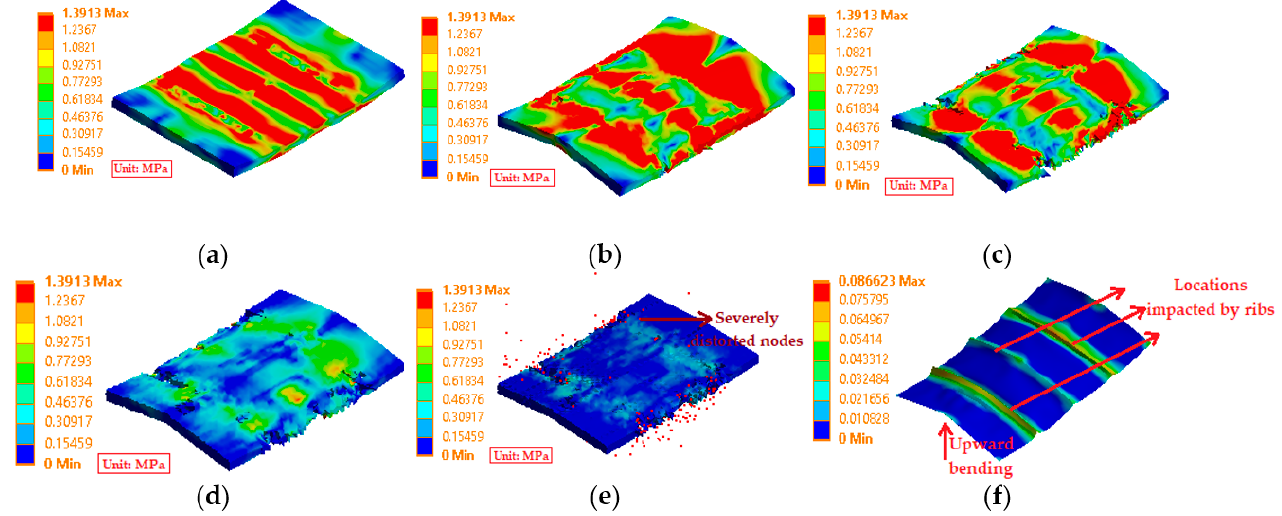
Figure 6. Maximum stress and damage configuration: ( a ) Foam at 0.003 s; ( b ) Foam at 0.03 s; ( c ) Foam at 0.057 s; ( d ) Foam at 0.1 s; ( e ) Final damage of foam at 0.015 s; ( f ) Effective plastic strain of Al plate.